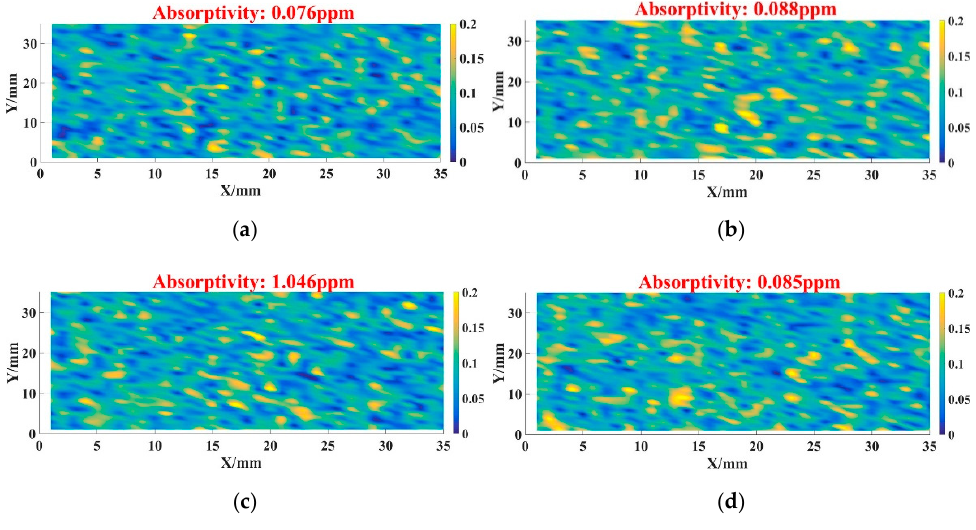
Figure 3. Absorptivity result of samples after DCE process: ( a ) 1 — absorptivity result; ( b ) 2 — absorp-